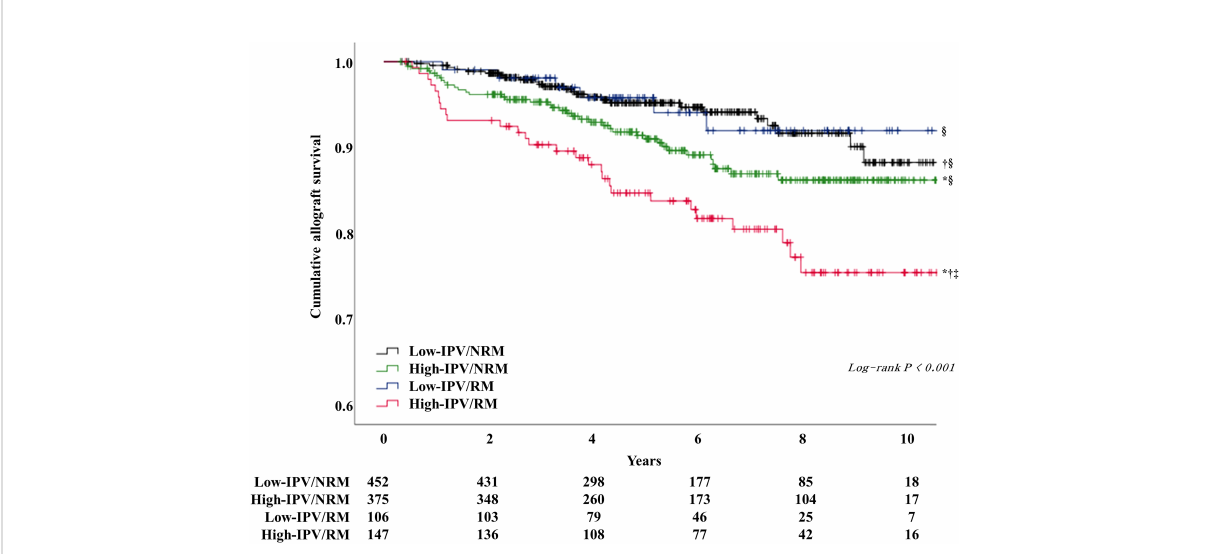
FIGURE 3 Kaplan – Meier survival curve analysis of allograft survival according to TAC-IPV and RM/NRM status. The high IPV/RM group had the lowest allograft survival rate. The high-IPV/NRM group showed intermediate outcomes, and the low-IPV group showed relatively good allograft survival rates regardless of NRM/RM status (log-rank P < 0.001). *Log-rank P <0.05 versus low-IPV/NRM group; † log-rank P <0.05 versus high-IPV/NRM group; ‡ log-rank P <0.05 versus low-IPV/RM group; § log-rank P <0.05 versus high-IPV/RM